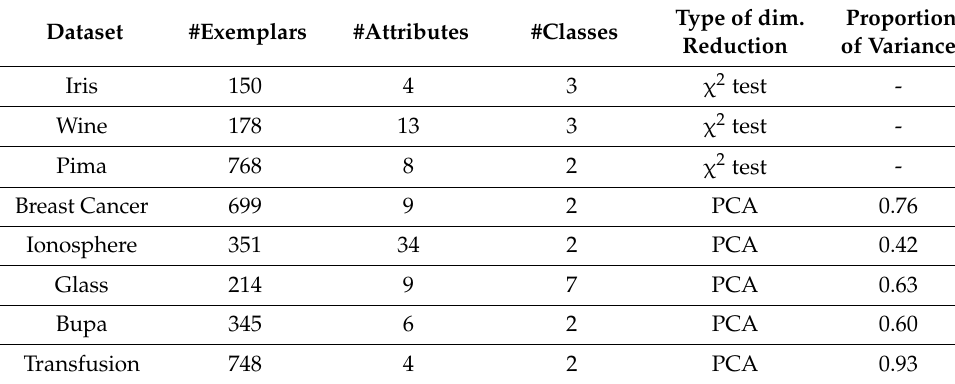
Table 1. Description of the datasets adapted and used for the